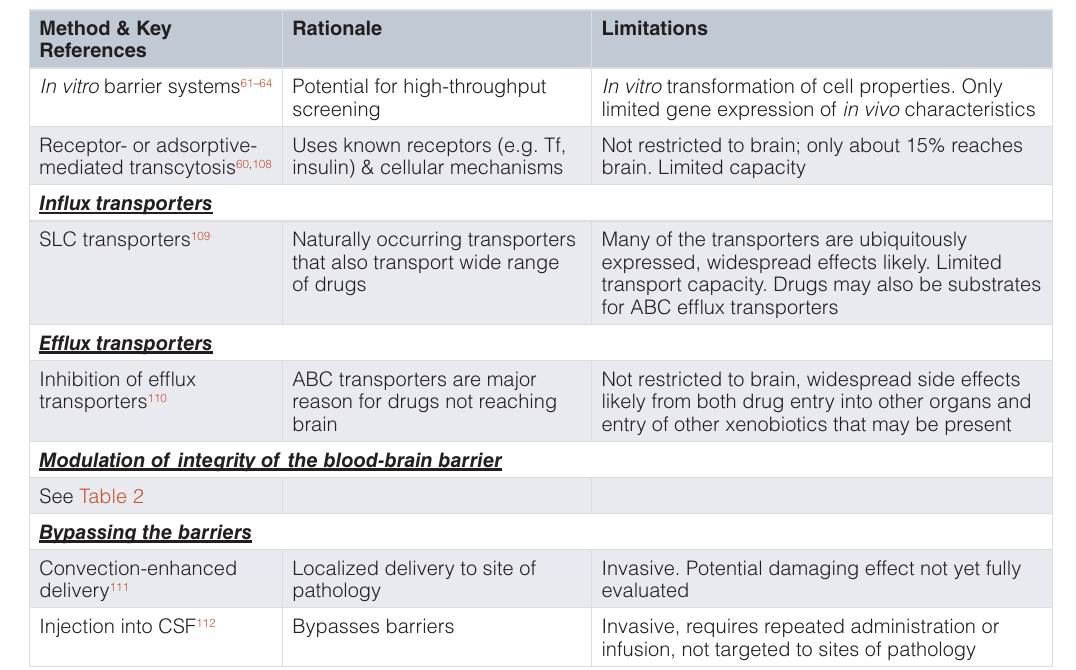
Table 1. Drug targeting to the central nervous